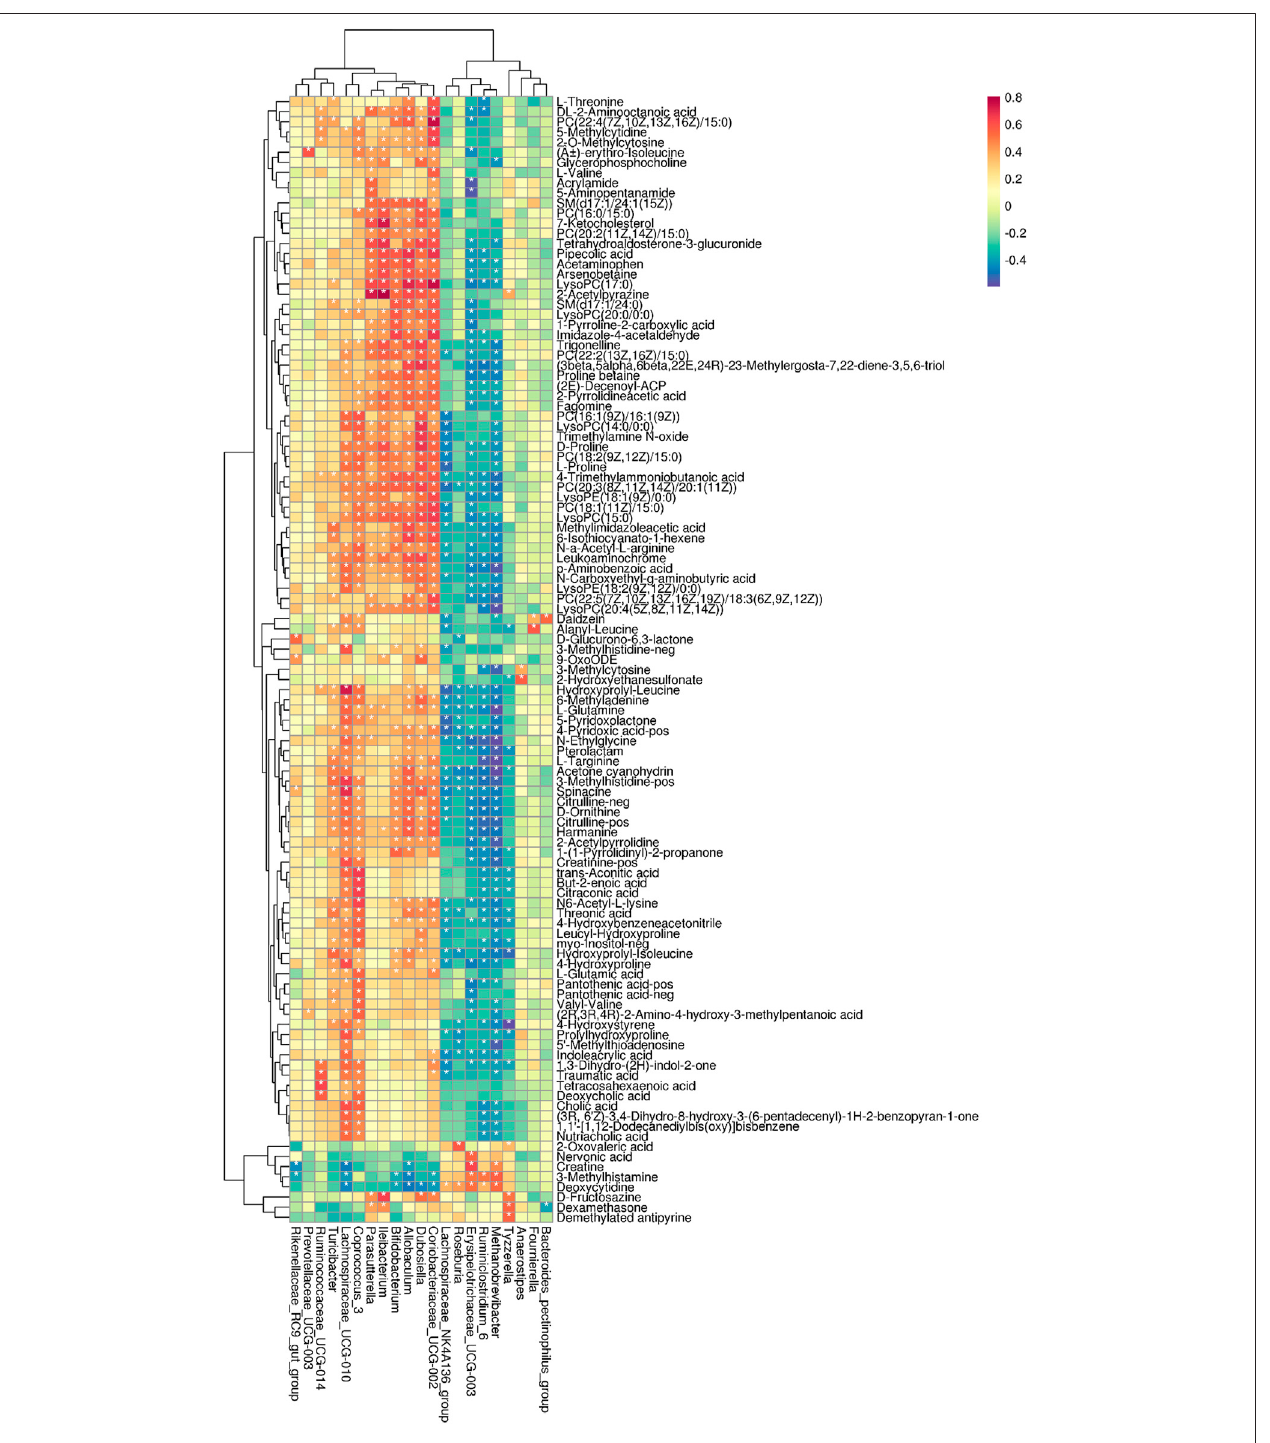
FIGURE 7 | Correlations between microbial abundances in the genus level and metabolic pro fi ling. * p < 0.05.